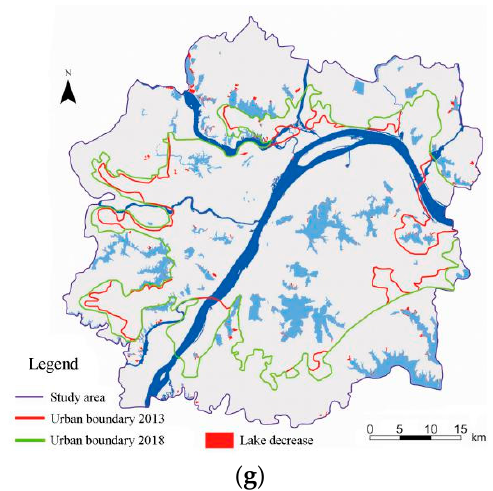
Figure 6. Urban expansion and lake changes in Wuhan urban development area from 1987–2018. ( a )